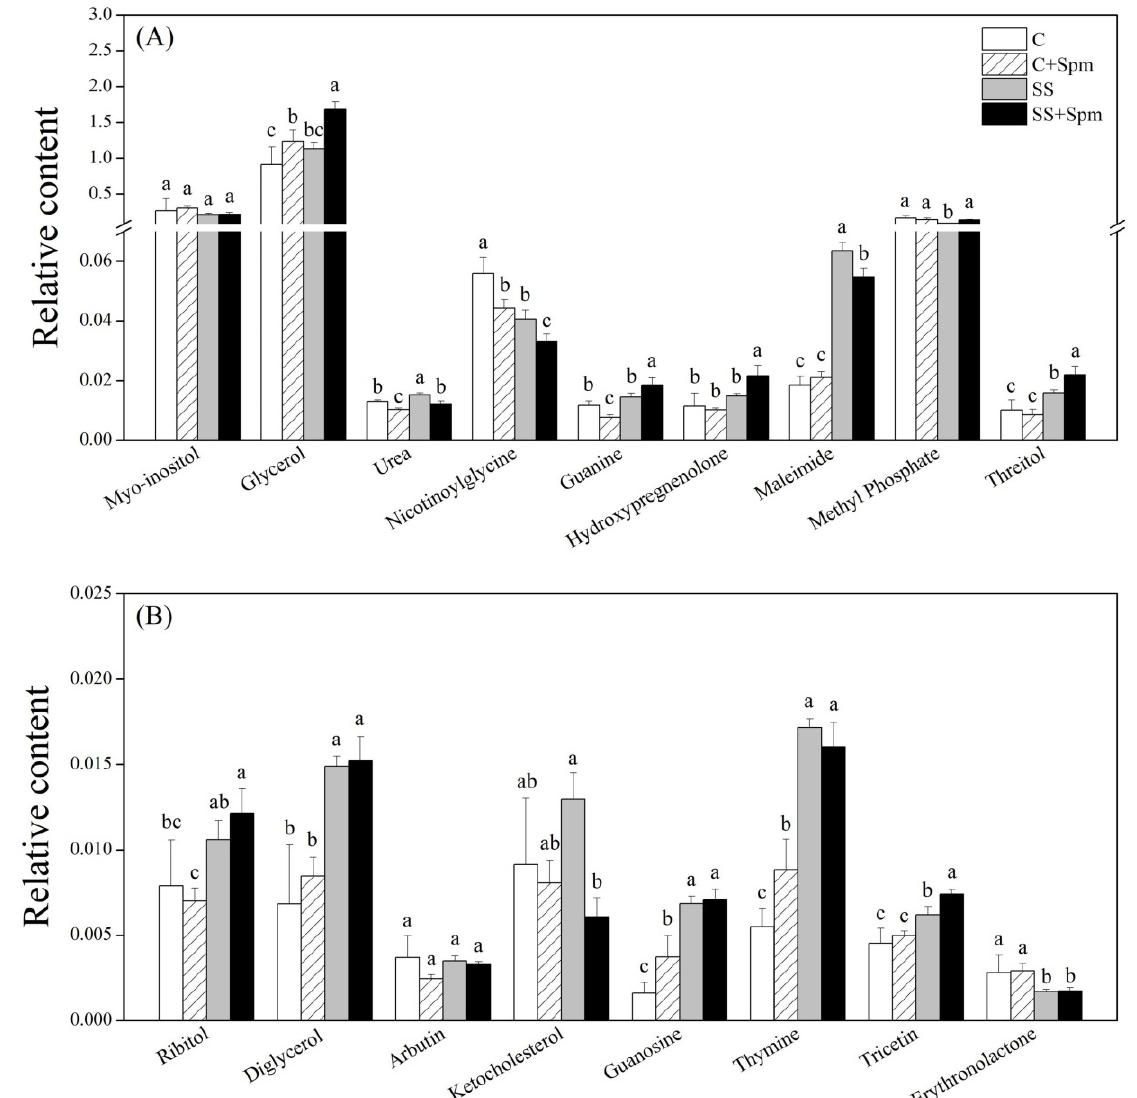
Figure 9. Effects of exogenous application of spermine (Spm) on ( A ) and ( B ) other metabolites under normal conditions and salt stress. Vertical bars indicate ±SE of mean (n = 4). Different letters above columns indicate significant differences based on LSD ( p < 0.05). C, control; C + Spm, control + Spm; SS, salt stress; SS + Spm, salt stress + Spm.